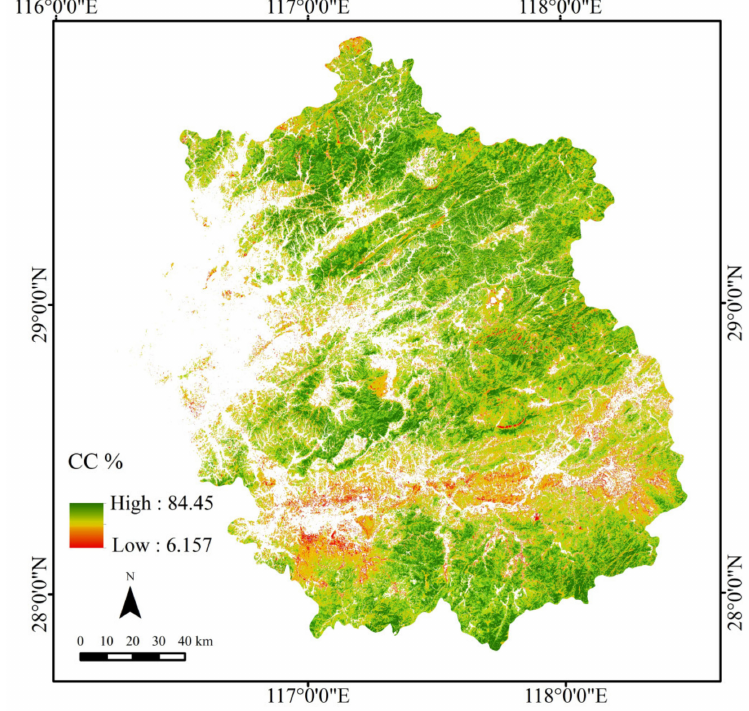
Figure 9. Forest and woodland canopy cover (CC) map of northeast